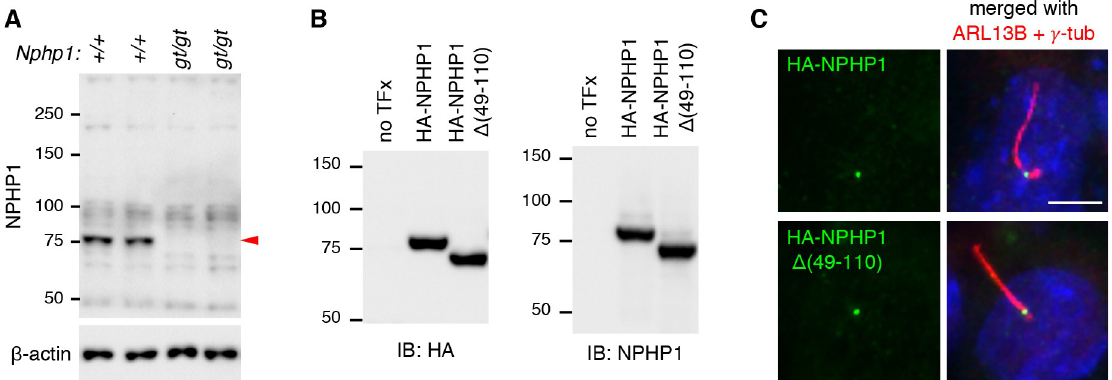
Fig 5. Expression and localization of NPHP1 Δ (49–110) deletion mutants. (A) Immunoblotting of NPHP1 (red arrowhead) in 35-day- old Nphp1 +/+ and Nphp1 gt/gt mouse testes. Fifty μ g of proteins were loaded per lane. β -actin was used as a loading control. (B) Expression of HA-tagged NPHP1 and NPHP1 Δ (49–110) in transiently transfected 293T/17 cells. Cell lysates were subjected to SDS-PAGE and immunoblotting (IB) with anti-HA and anti-NPHP1 antibodies. (C) Localization of NPHP1 Δ (49–110) to the transition zone in mIMCD-3 cells. HA-NPHP1 and HA-NPHP1 Δ (49–110) were transiently transfected to mIMCD-3 cells and their localization was probed with anti- HA antibodies (green). ARL13B and γ -tubulin (red) were immuno-labeled to mark primary cilia and basal bodies, respectively. DAPI (blue) was used to counterstain the nuclei. Scale bar represents 2 μ